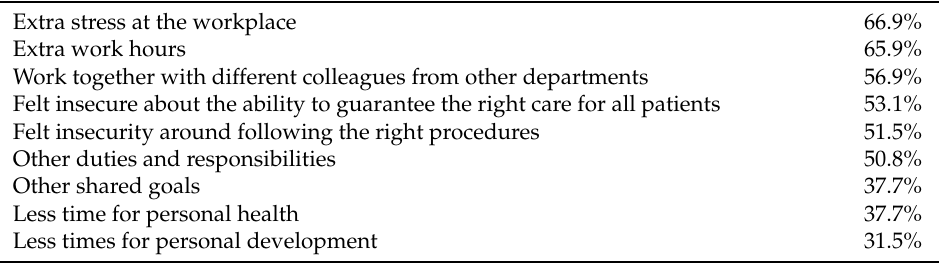
Table 2. Overview of the effects of COVID-19 pandemic on healthcare employees in our sample. Extra stress at the workplace 66.9% Extra work hours 65.9%